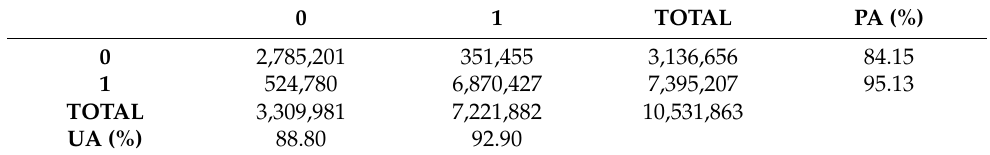
Table 4. Error matrix for Brentelle. 0 = not green; 1 = green. Rows = visual analysis; columns = NDVI + Topographic DB. UA = user’s accuracy; PA = producer’s accuracy.